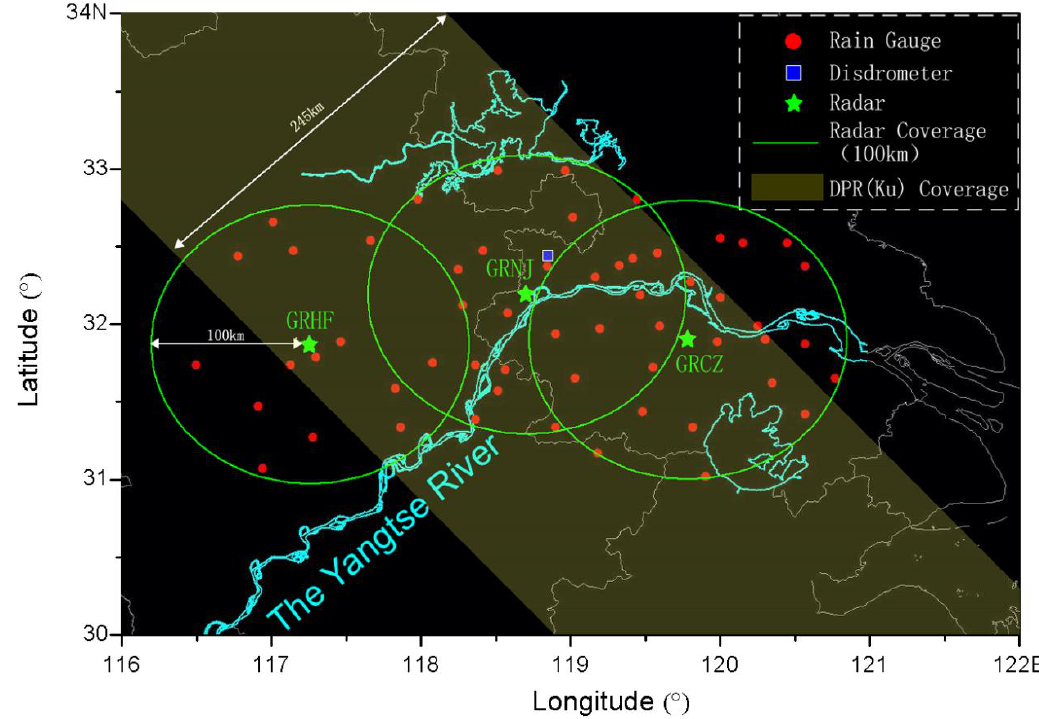
Figure 1. The locations and 100 km radius coverages of three ground radars, locations of operational rain gauges and a disdrometer, schematic coverage of GPM/KuPR.